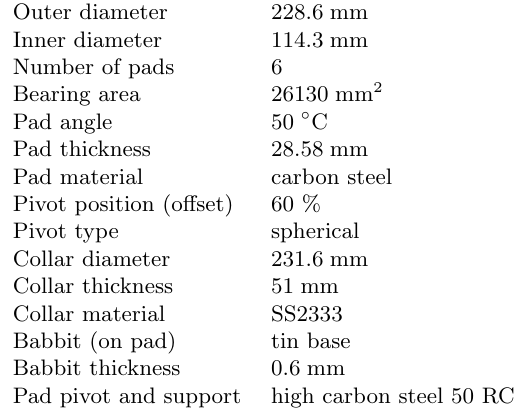
Table 3: Test bearing characteristics (Glavatskikh, 2000; Glavatskikh and Larsson, 2000). Outer diameter 228 . 6 mm